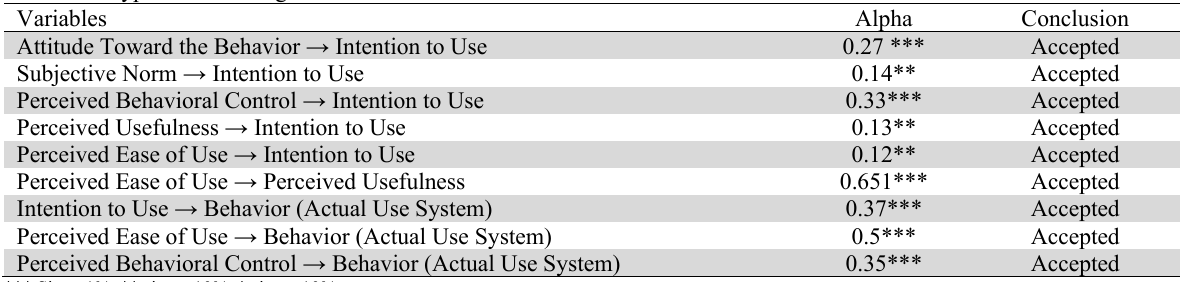
Results of Hypothesis Testing